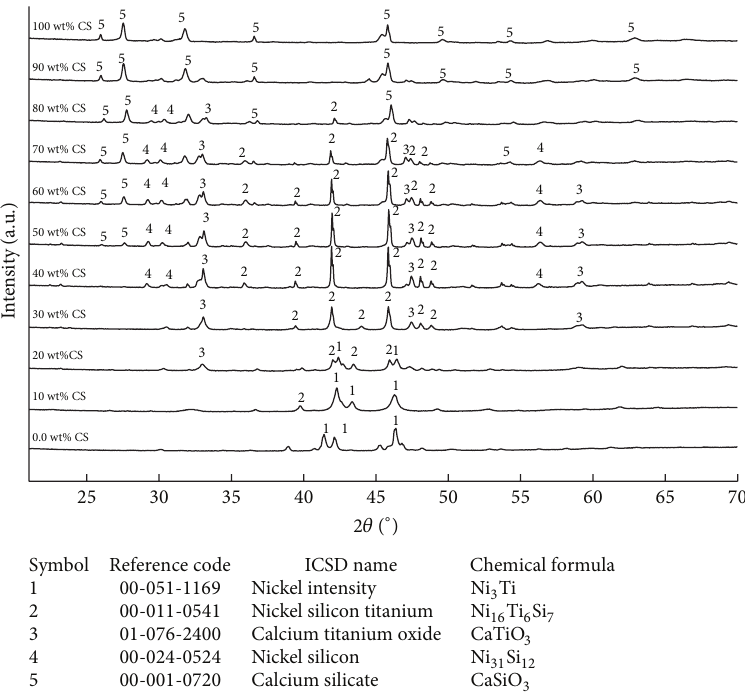
Figure 6: XRD patterns of Ti-55Ni/CaSiO 3 sintered cermets with different CS contents. New phases are revealed from 10 to 80 wt% CS contents in TN/CS cermets.